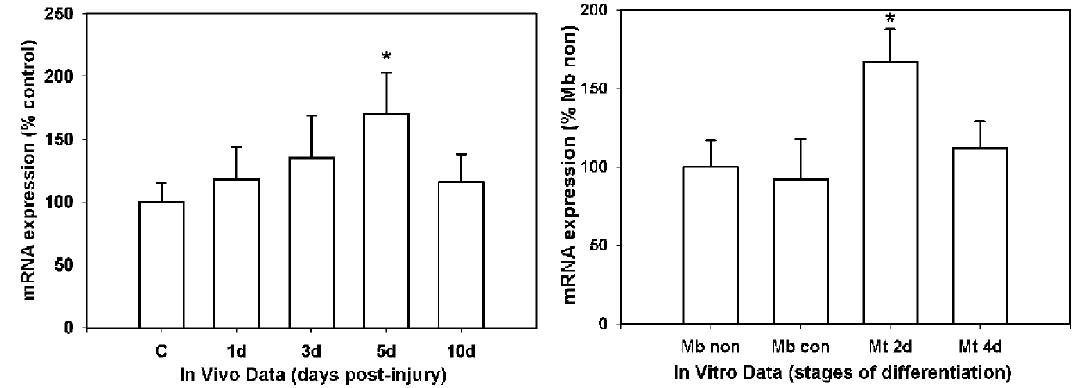
FIGURE 5. Leptin expression in skeletal muscle following injury and in muscle cells at different stages of differentiation. Leptin mRNA expression was evaluated by PCR, normalized to GAPDH expression, and displayed as percentage of uninjured control (left) or nonconfluent myoblast (right) values. Left: Leptin expression in uninjured control (C) muscle and muscles collected on days 1–10 postinjury. Right: Leptin expression in cultured C2C12 muscle cells at different stages of growth. Mb non: nonconfluent myoblasts; Mb con: confluent myoblasts; Mt 2d: myotubes 2 days after initiation of differentiation; Mt 4d: myotubes 4 days after initiation of differentiation. Bars are means ± standard error, n = 4 per time point. * = Mean value significantly larger than value for control muscles or nonconfluent myoblasts; p <